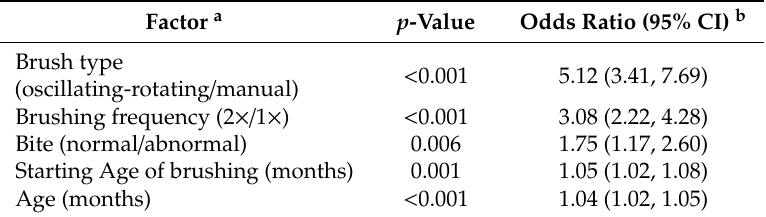
Table 3. Factors contributing to the gingivitis model.